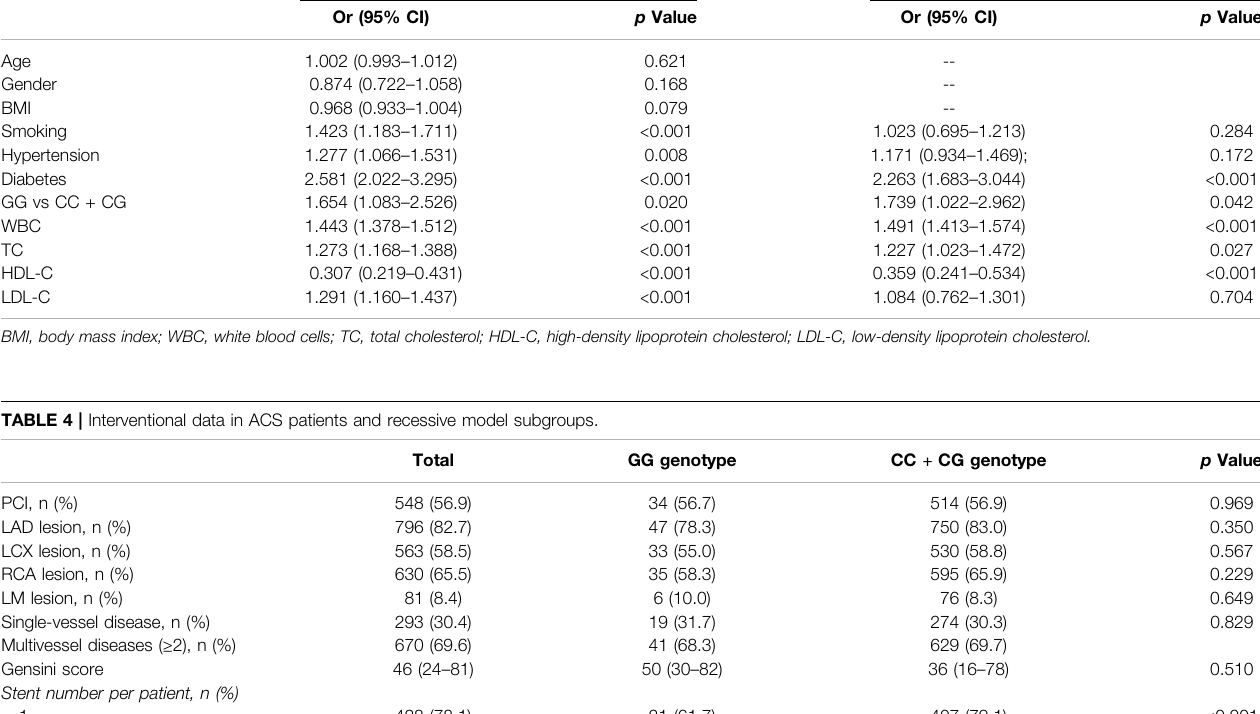
TABLE 3 | Multivariate logistic regression analysis. Unadjusted Adjusted for clinical variables